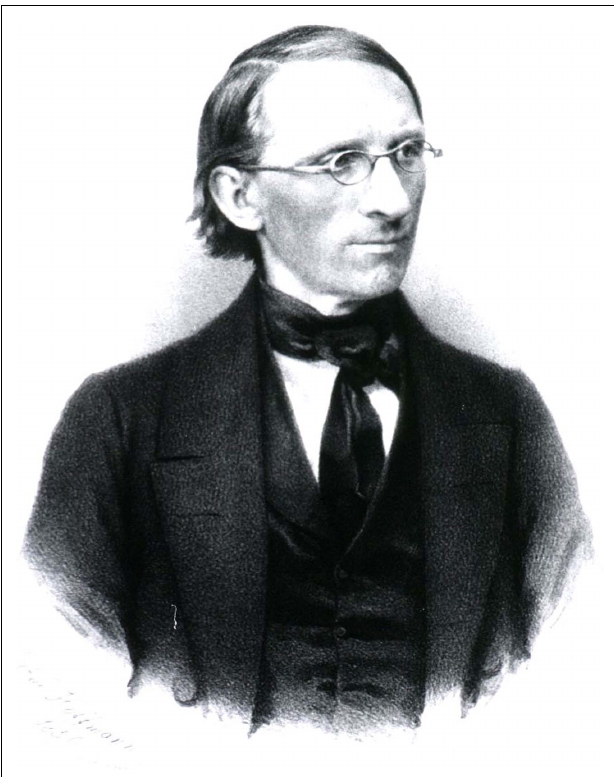
FIGURE 6 | Photograph of Carl Lugwig (1816–1895). He is credited with inventing the smoked drum kymograph and used it to record periodic oscillations in the amplitude and timing of arterial pressure that varied during respiration. Using the dog, he reported that the pulse rate increased during inspiration and decreased during expiration, thereby providing the first documented recordings of the respiratory sinus arrhythmia. Source: National Library of Medicine (the history of medicine public domain image files). Picture made in